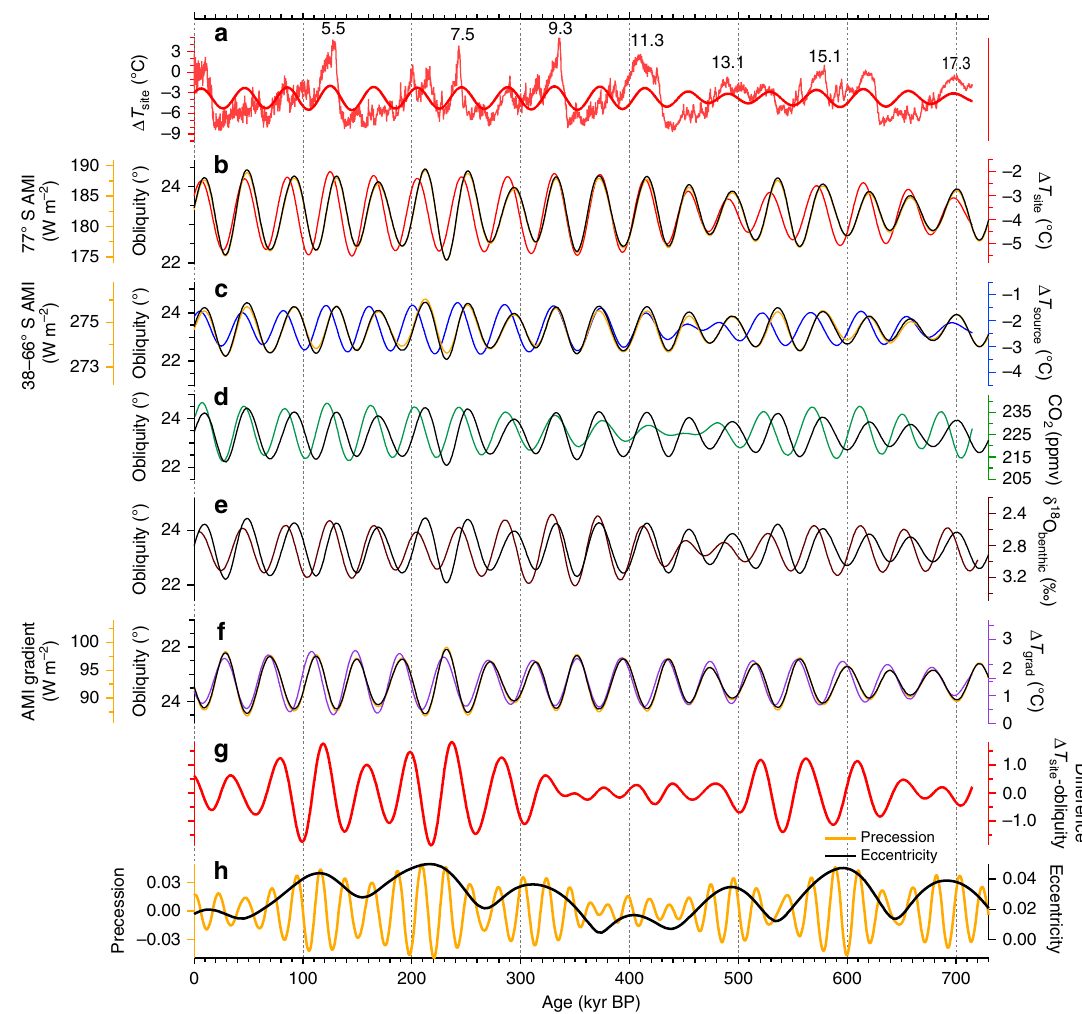
Fig. 4 Obliquity components of climate records and orbital parameters. a DF Δ T site (thin red) and its obliquity component (red). b The obliquity component of Δ T site (red), AMI at 77° S (yellow) and obliquity (black). c The obliquity component of Δ T source (blue), AMI at 38 – 66° S (yellow) and obliquity (black). d The obliquity component of the CO 2 composite record 32 (green) and obliquity (black). e The obliquity component of benthic δ 18 O record 40 and obliquity (black). f The obliquity component of Δ T grad (purple), the insolation gradient between 77° S and 38 – 66° S (yellow) and obliquity (black, axis inverted). g The differences between the normalized obliquity component of Δ T site and AMI at 77° S (red). h Orbital eccentricity (black) and precession (yellow). The insolation curves are shown behind the obliquity variations. The obliquity components were calculated using a bandpass fi lter